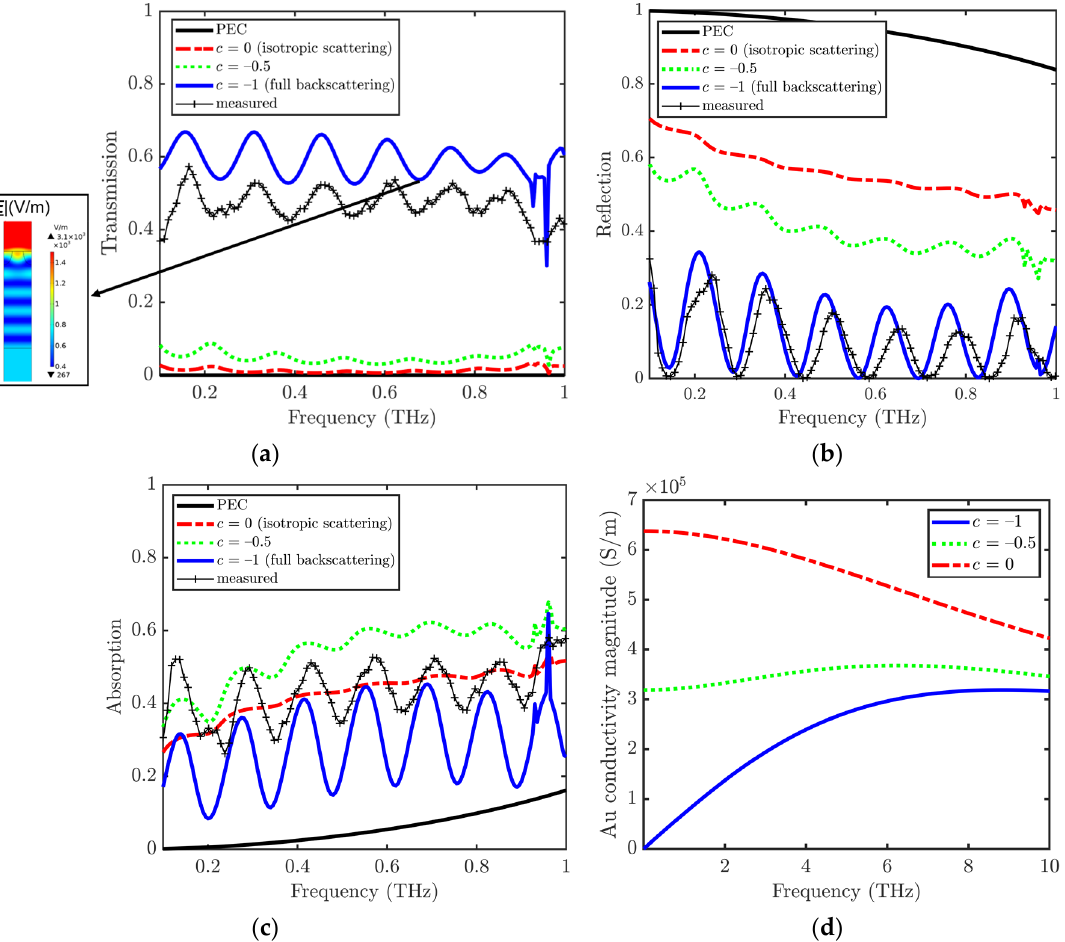
Figure 5. Simulated power ( a ) transmission, ( b ) reflection, and ( c ) absorption spectra of the gra- phene/gold/patterned SiO 2 metastructure computed by FEM simulations, at different c correspond- ing to different conditions of gold nonideality, exciting the top port with a THz electric field parallel to the grooves and normally incident on the device top surface, in the frequency range of 0.1–1 THz. ( d ) The magnitude of the gold layer complex conductivity in the frequency range 0.1–1 THz. Inset of ( a ): electric field magnitude distribution in the cross-section surface at f = 0.685 THz, in corre- spondence with a minimum of T and R and a maximum of A. In order to evidence the grooves’ location, h and t pb parameters are also reported here.